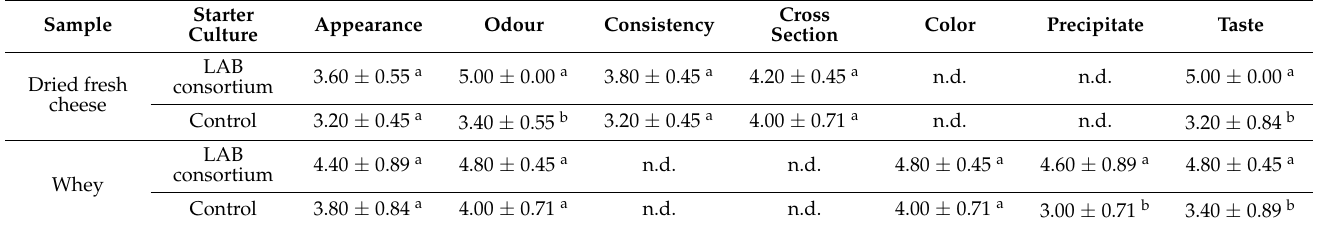
Table 3. Preference test scores for dried fresh cheeses and separated whey, made by the LAB consortium and commercial starter culture